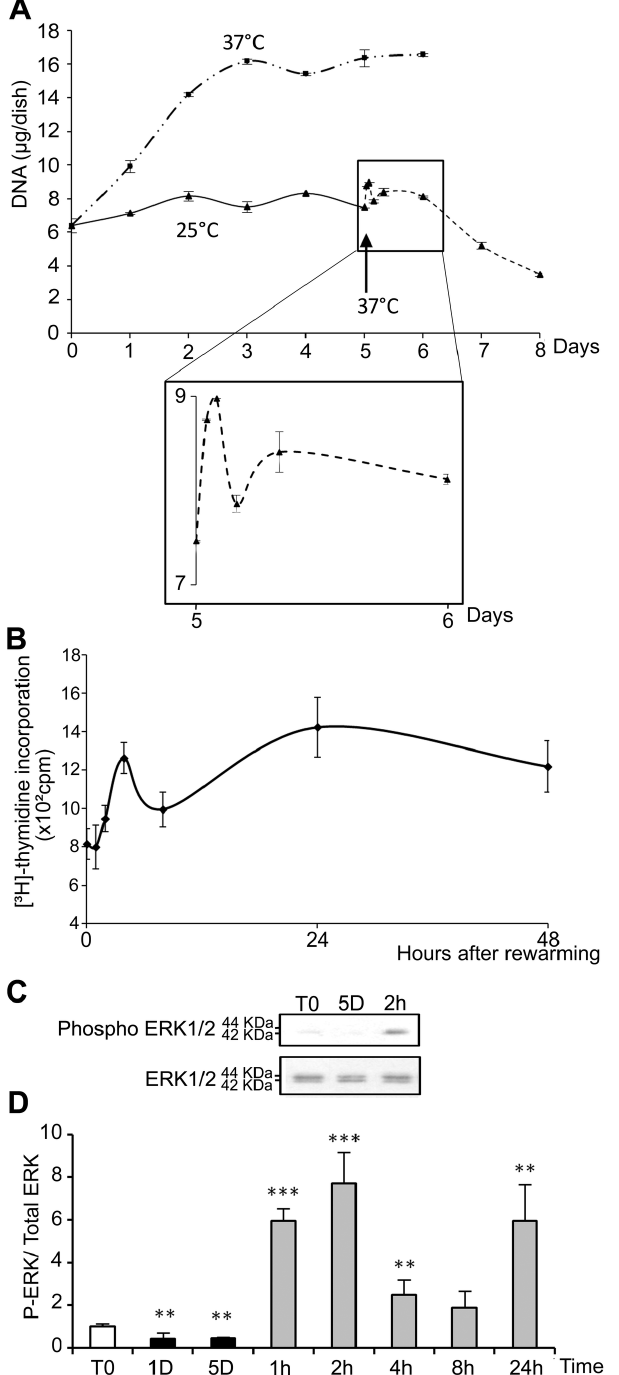
Figure 2. Temperature dependence of cell proliferation. (A) WI26 cells maintained at 37°C for 1 to 6 days (— - - —) or at 25°C for 1 to 5 days (——) and then warmed at 37°C for 1 to 72 hours (- - - -), and DNA content was measured. The black arrow indicates the transition from 25°C to 37°C. Insert provides an enlarged view of the first 24 hours of rewarming at 37°C. (B) [ 3 H]-thymidine incorporation by WI26 cells maintained for 5 days at 25°C and warmed at 37°C for 1 to 48 h. (C) Representative western blot probed with antibodies specific for phospho ERK 1/2 or total ERK 1/2. (D) Quantification of the western blots. Data are expressed as the mean ratio of P-ERK/ total ERK normalized to ratio in control cells (T0), taken as 1. T0: 1 day at 37°C; 1D and 5D: 1 or 5 days at 25°C; 1h, 2h, 4h, 8h and 24h: 5 days at 25°C followed by 1 to 24h at 37°C. doi: 10.1371/journal.pone.0069687.g002 PLOS ONE |